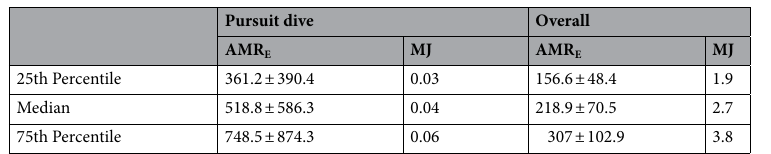
Table 2. Estimated active metabolic rate (AMR E ; mgO 2 kg −1 h −1 ) and energy expenditure (MJ) during the dive where the predation occurred, and overall for the 24 h period for the 25th, median and 75th percentile of the 10,000 iterations of randomly sampled parameter estimates used to calculate AMR E . Values are presented as mean ± SD where